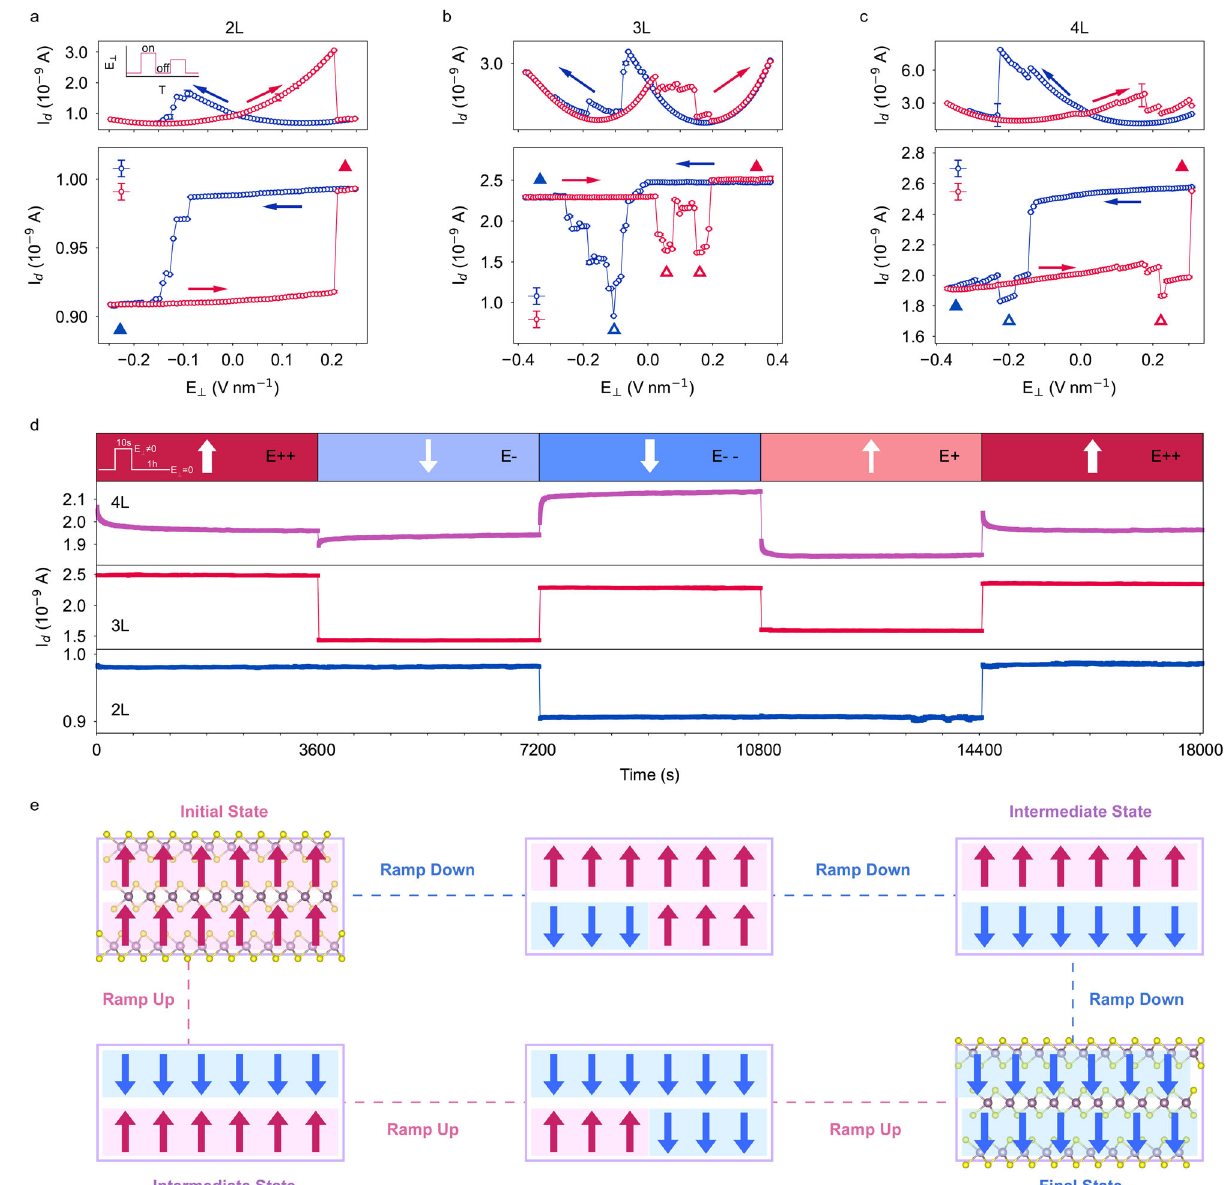
Fig. 3 | Static transport properties ofdual-gate FET devices in the ferroelectric switchingprocess.a – c Theaveraged I d asafunctionof E ⊥ inon- fi eld(upperpanel) measurements and off- fi eld (lower panel) measurements in devices with different layernumbers.Thesolidtrianglesindicatethelocationsoftheinitialand fi nalstates in the loop, and the hollow triangles indicate the locations of the intermediate anomalous states. The arrows indicate the sweep direction. The inset in a is a